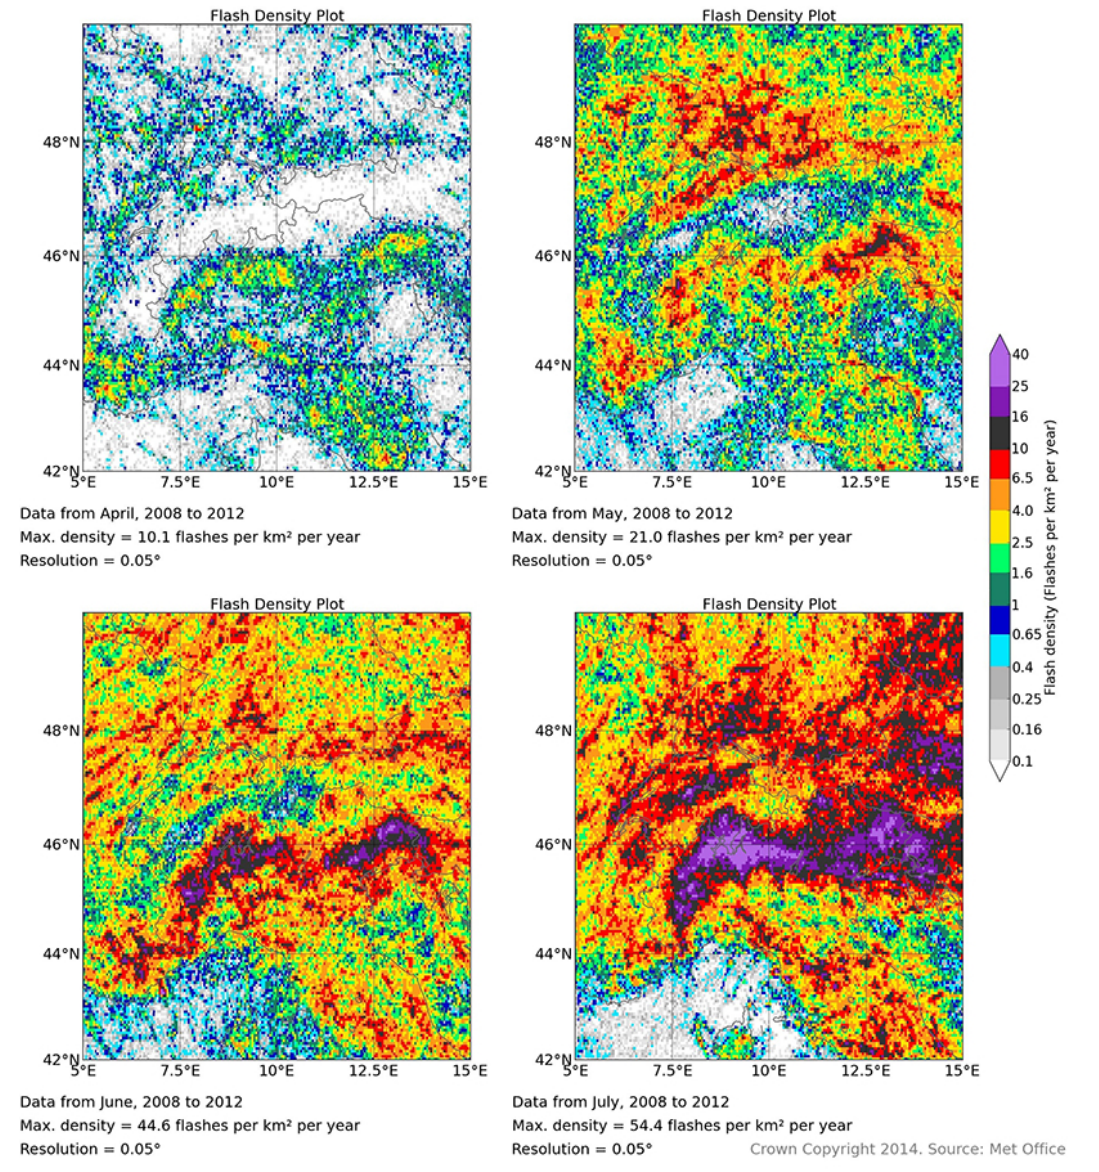
Fig. 18. Detected lightning flash density for the Alps, for April (top left), May (top right), June (bottom left) and July (bottom